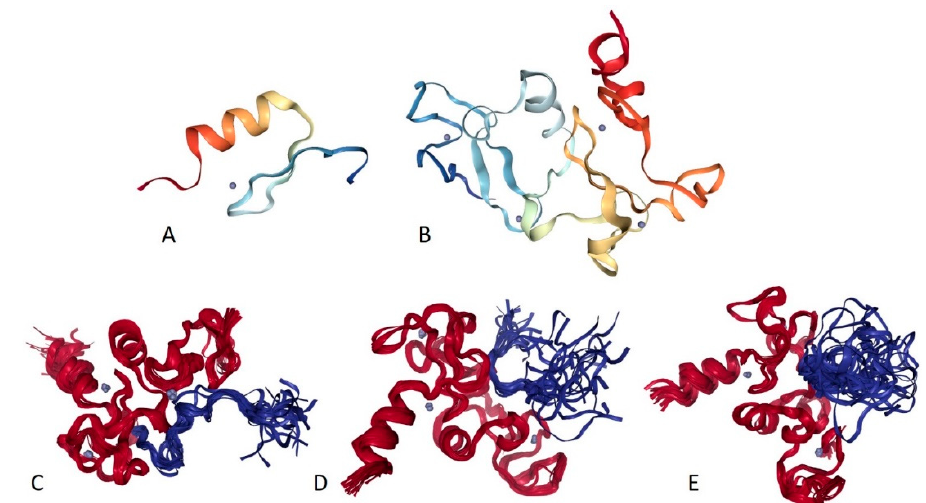
Figure 20. Structural characterization of human DPF2 / BAF45D and DPF3 / BAF45C proteins. X-ray crystal structures of C2H2-type zinc finger domain ( A ; PDB ID: 3IUF) and double PHD finger domain of human DPF2 / BAF45D ( B ; PDB ID: 5B79). NMR solution structures of the double PHD fingers of human transcriptional protein DPF3 / BAF45C (red structures residues 261–372) bound to: ( C ) Histone H3 peptide acetylated at lysine 14 (PDB ID: 2KWJ; blue structures); ( D ) Histone H4 peptide containing acetylation at lysine 16 (PDB ID: 2KWN; blue structures); and ( E ) Histone H4 peptide containing N-terminal acetylation at serine 1 (PDB ID: 2KWO; blue